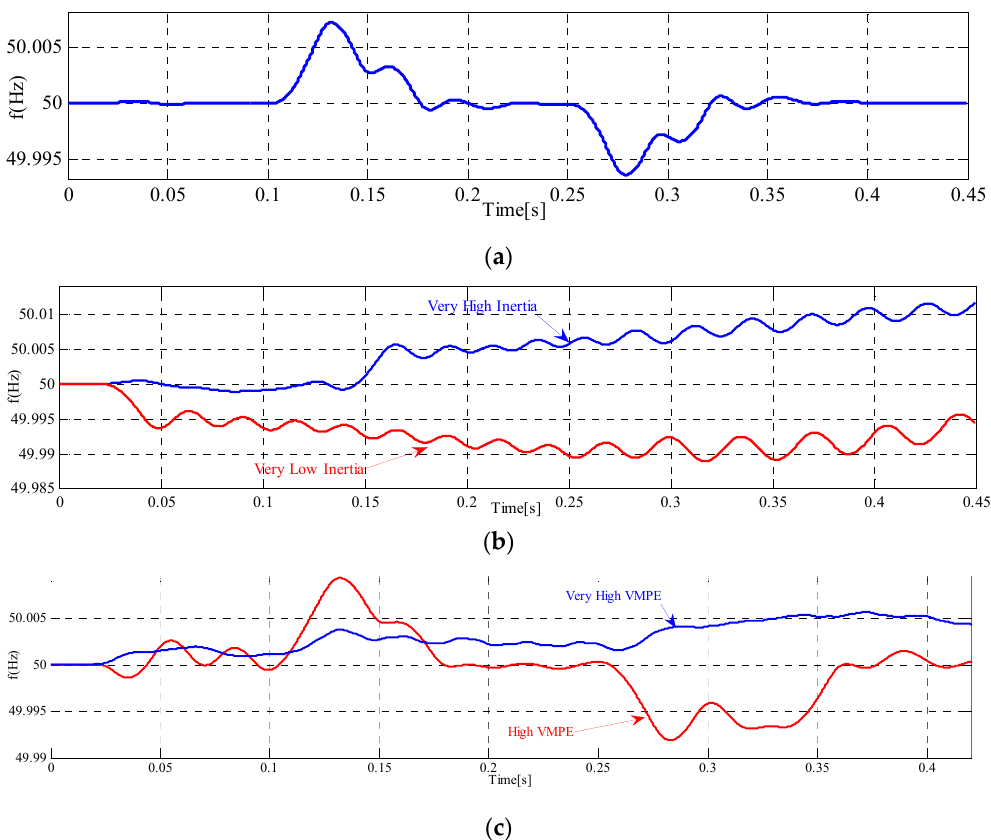
Figure 11. The grid frequency under ( a ) appropriate virtual inertia and VMPE, ( b ) very high and low virtual inertia, and ( c ) high and very high values of VMPE.